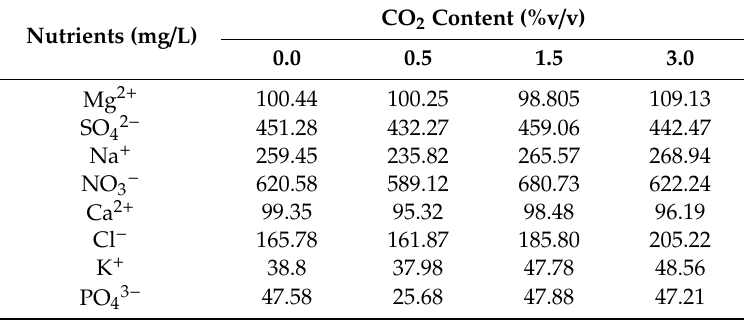
Table 2. Initial concentration of nutrients during the S. almeriensis